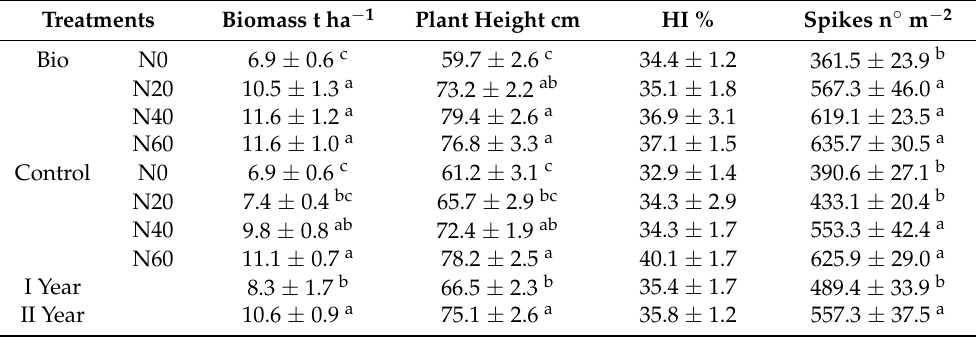
Table 3. Biomass production, plant height, harvest index (HI) and number of spikes per square meter of barley as affected by biostimulant (treated with biostimulant = Bio and not treated = Control) and nitrogen fertilization levels (not fertilized = N0; fertilized with 20 kg N ha − 1 = N20; fertilized with